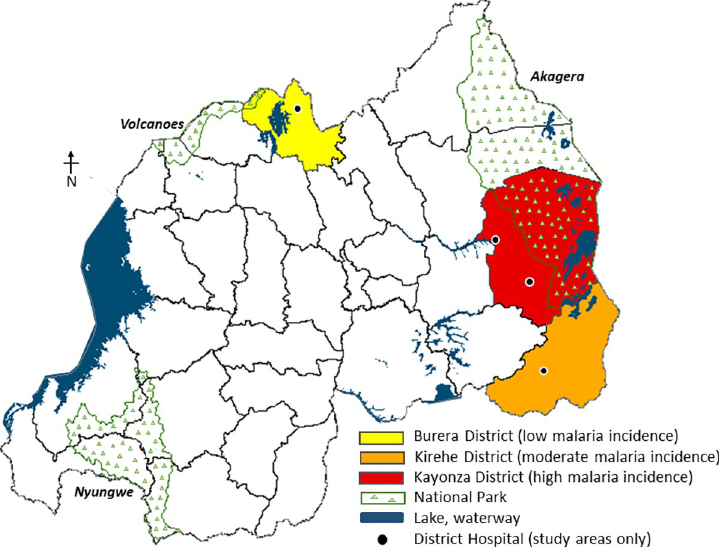
Fig 2. Map of Rwanda illustrating the three districts selected to participate in this study (malaria incidence as per [22]).